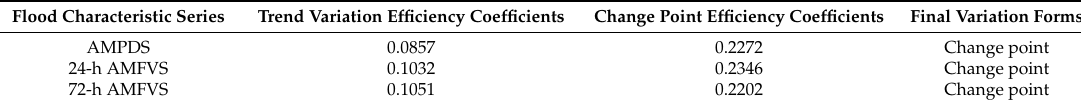
Table 6. Calculation results of the efficiency coefficients.